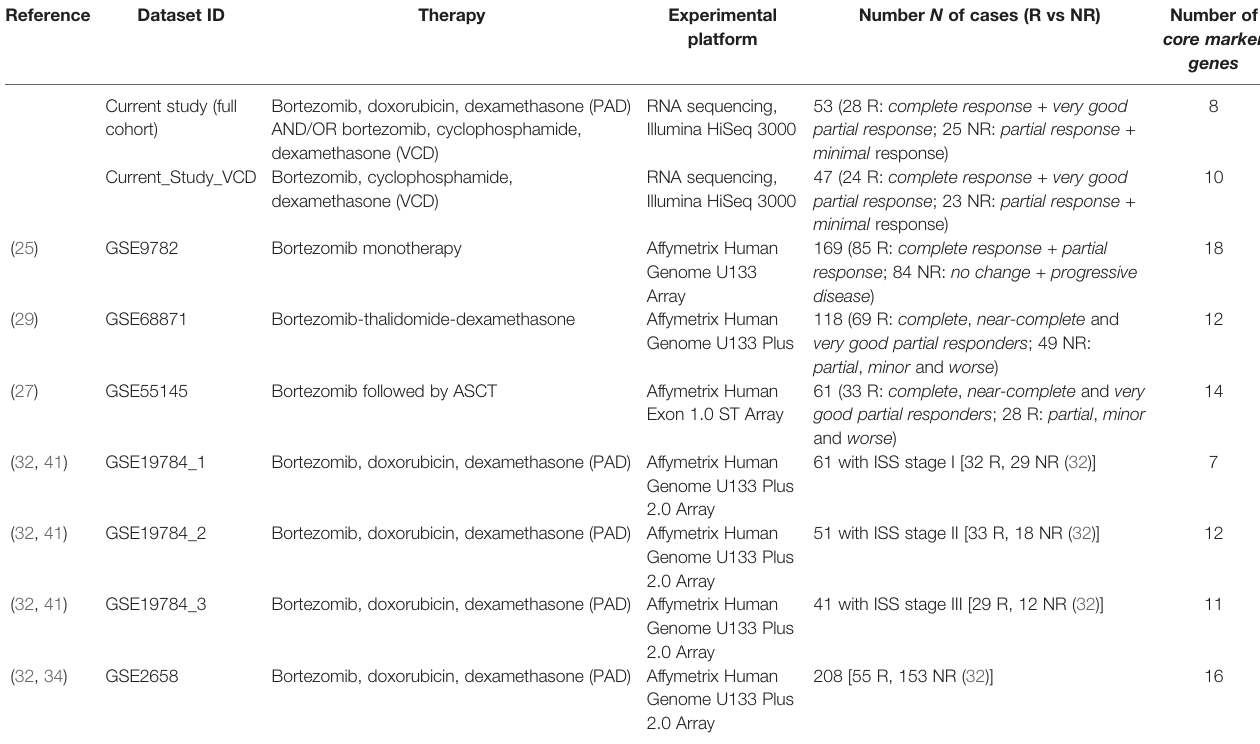
TABLE 3 | General characteristics of bortezomib chemotherapy response-annotated MM datasets.